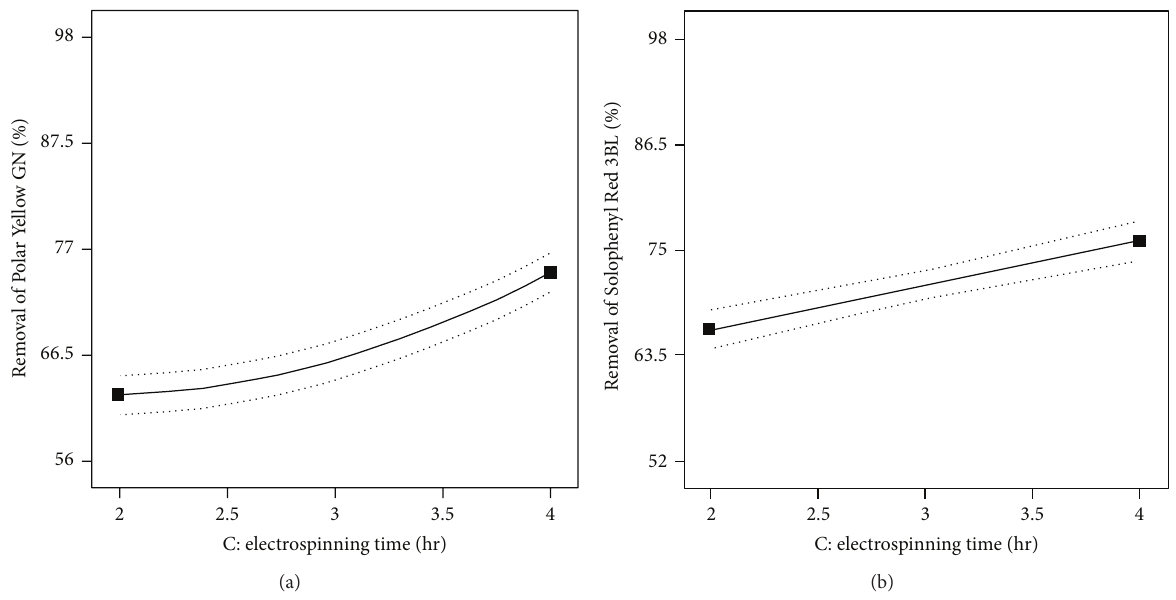
Figure 9: Effect of electrospinning time on the removal of acidic and direct dyes.